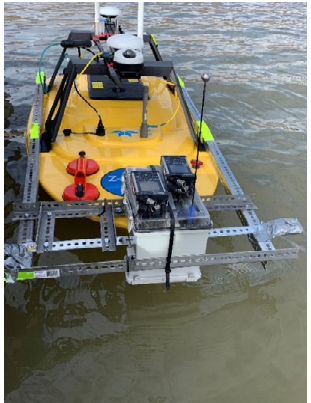
Figure 10. Newer BRUTUS system on USV.